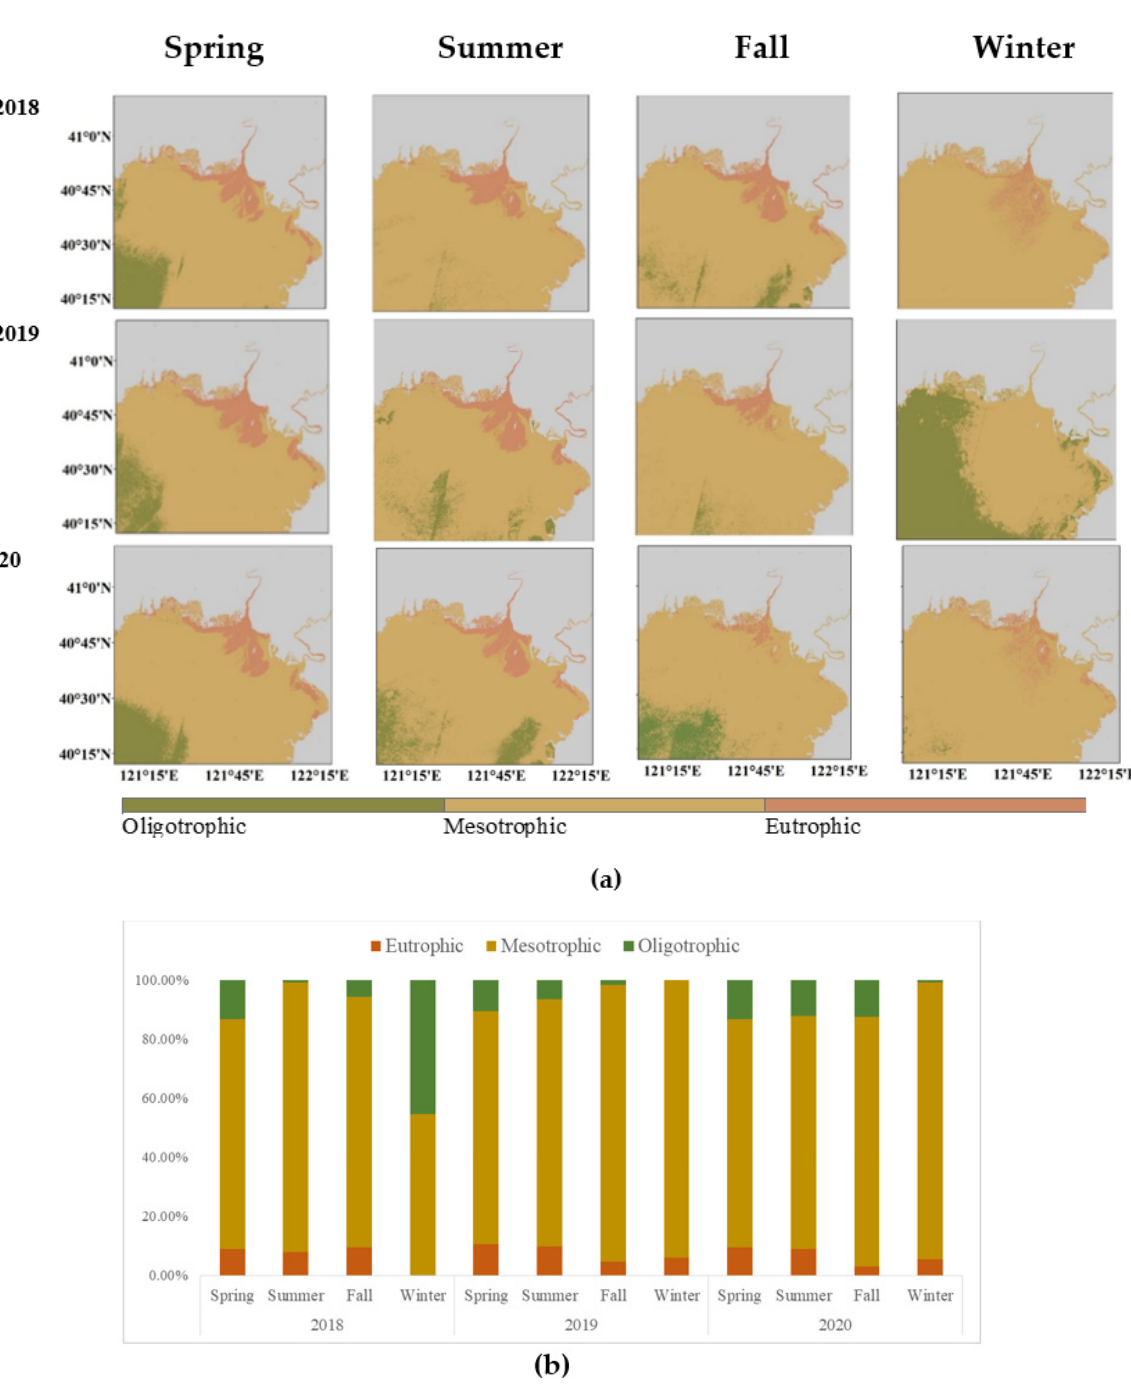
Figure 11. ( a ) Spatial distribution and variation of the eutrophication status in Liaodong Bay in 2018–2020; ( b ) the percentage of each trophic state in terms of surface area. The seasonal variations of the area of oligotrophication, mesotrophication, and eu- trophication from 2018 to 2020 were obtained. Figure 11 shows that the significant differ-